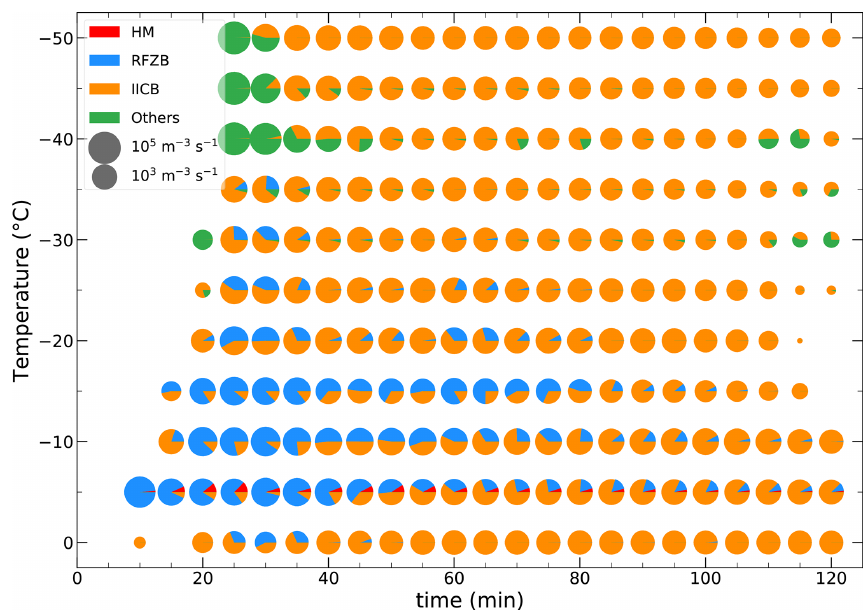
Figure 8. Time evolution of the averaged microphysical process rates relevant for ice particle production processes including (red) the H–M mechanism, (blue) shattering of freezing droplets, (orange) fragmentation of ice–ice collision, and (green) other microphysical processes (i.e., ice nucleation, homogeneous and heterogeneous freezing of cloud droplets and rain) in regions with IWC > 1gm − 3 at different temperatures. The pie charts denote ice particle production rates summed over all the source terms with the area of each color proportional to the ice particle production